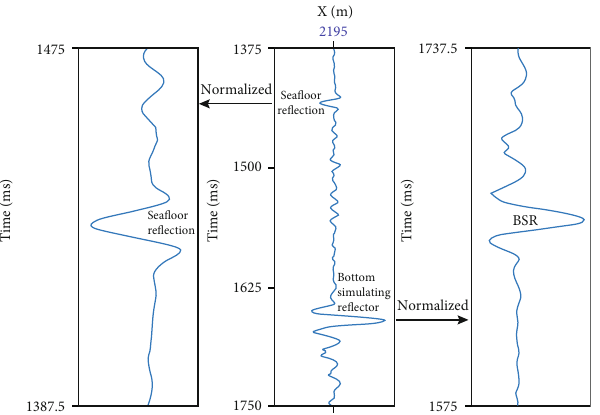
Figure 7: Seismic trace at X = 2195 m on the fi rst-order ghost imaging section in Figure